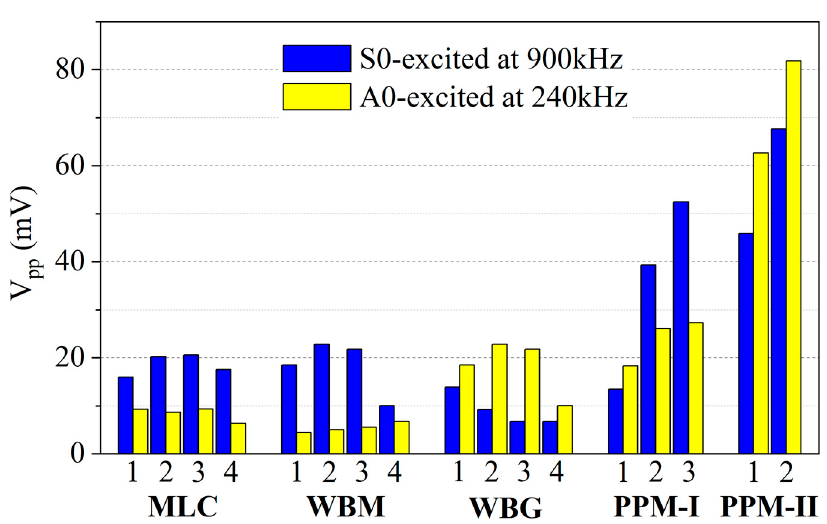
Figure 21. Comparison of the signal amplitudes received by means of different types of EMATs.